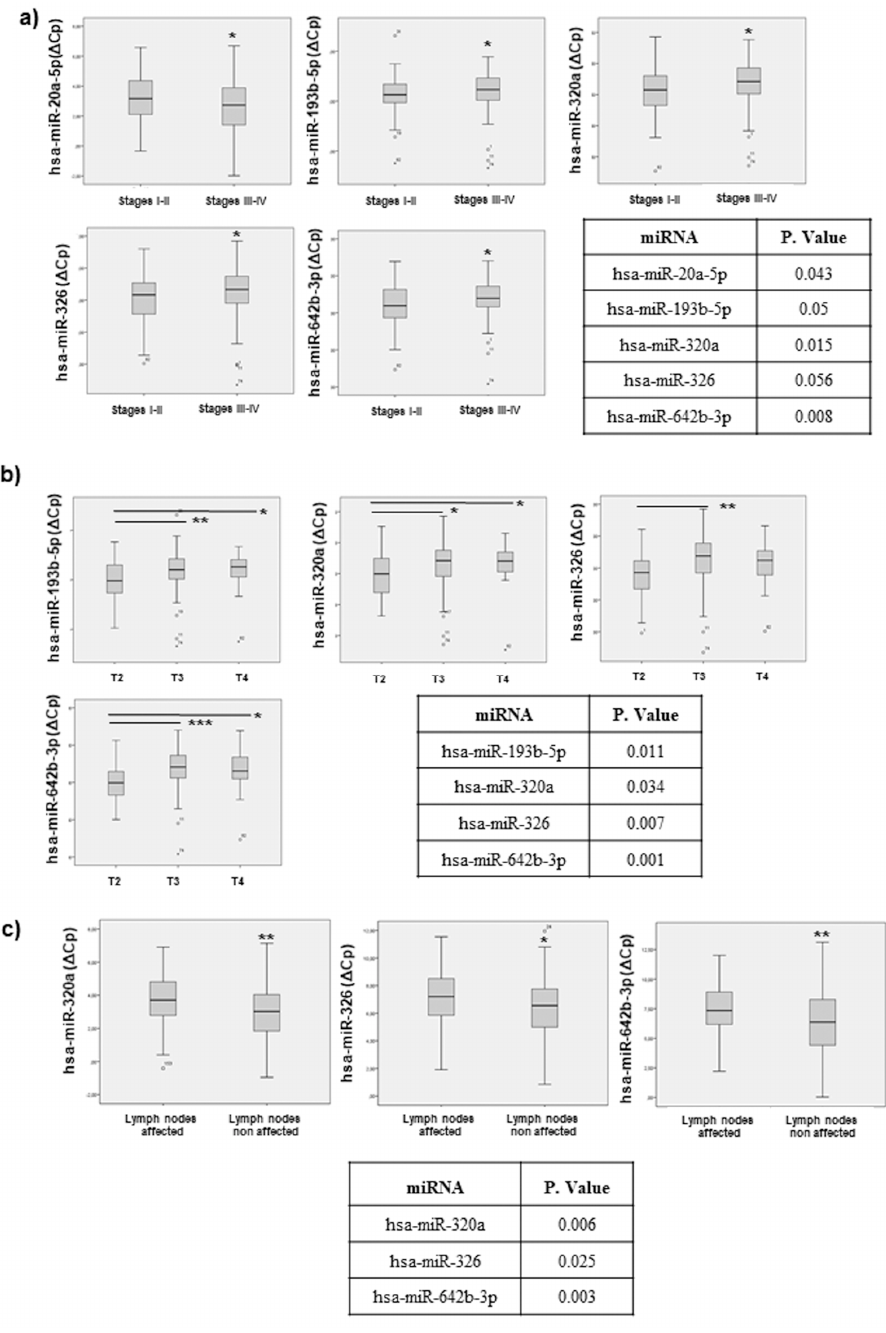
Figure 4. Statistical correlation between selected miRNAs and TNM stage (tumour-node-metastasis TNM staging system), tumour invasion and progression. Statistical analysis using SPSS 19.0 between miRNA levels expressed as DCT was performed. Only miRNAs exhibiting statistically significant correlations are shown. Data are presented as median and interquartile range with p values < 0.05. ( a ) data regarding correlation with tumour stage ( b ) tumour invasiveness and ( c ) lymph node affection are presented. * p < 0.05, ** p < 0.01, *** p < 0.001.